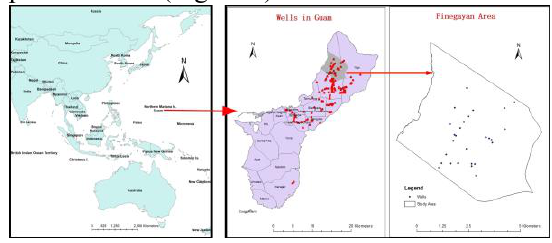
Figure 1. Location of Study Area Available data for the research include boundary data for basins and Guam municipalities,